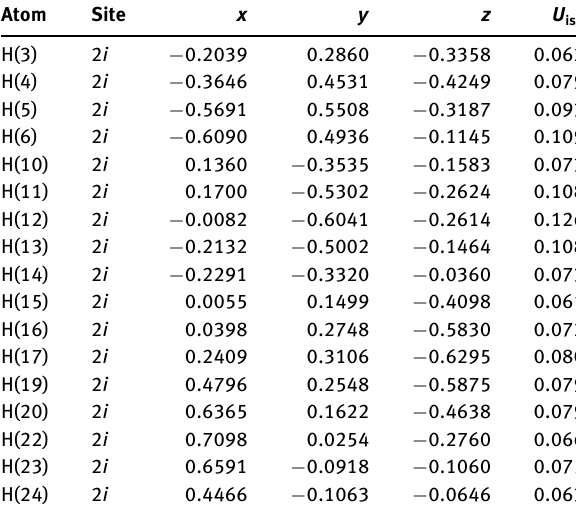
Table 2: Fractional atomic coordinates and isotropic or equivalent isotropic displacement parameters (Å 2